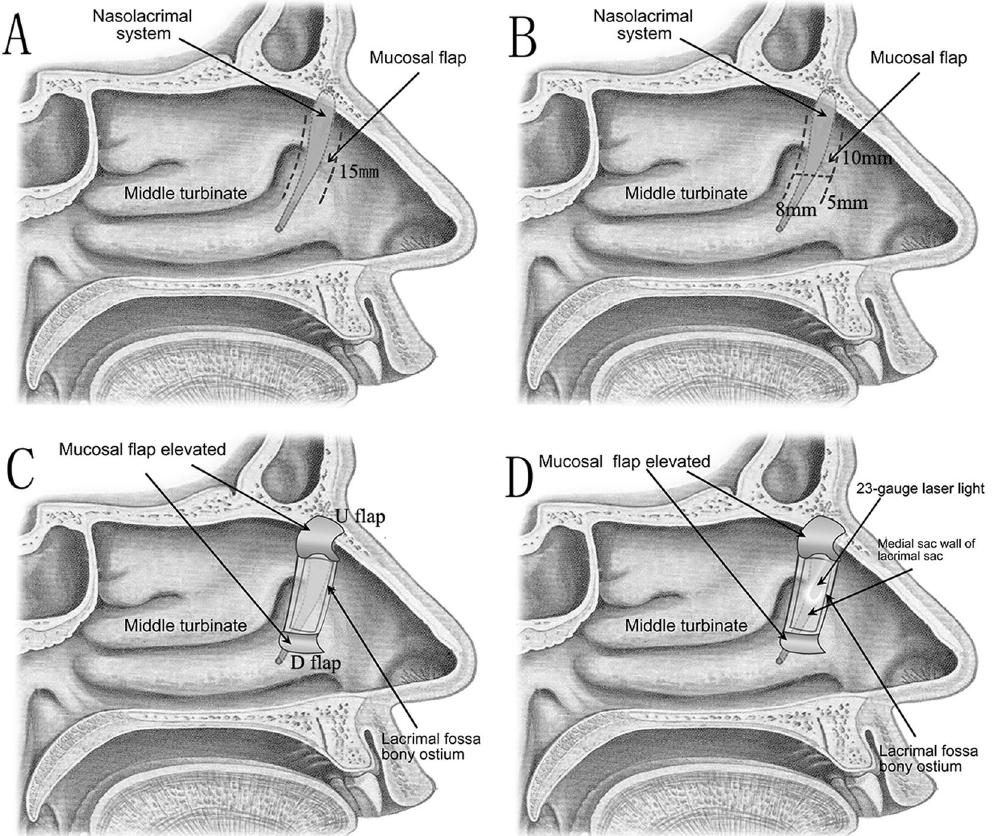
Figure 1. A Modified Preserved nasal and lacrimal mucosal flap Technique in Endoscopic Dacryocystorhinostomy. ( A and B ) Localization of nasal mucosal flap. ( C ) Open bony ostium, and expose lacrimal sac. ( D ) The 23-gauge laser light trans-illuminates and tents up the medial sac wall to confirm the surgical position in the lacrimal